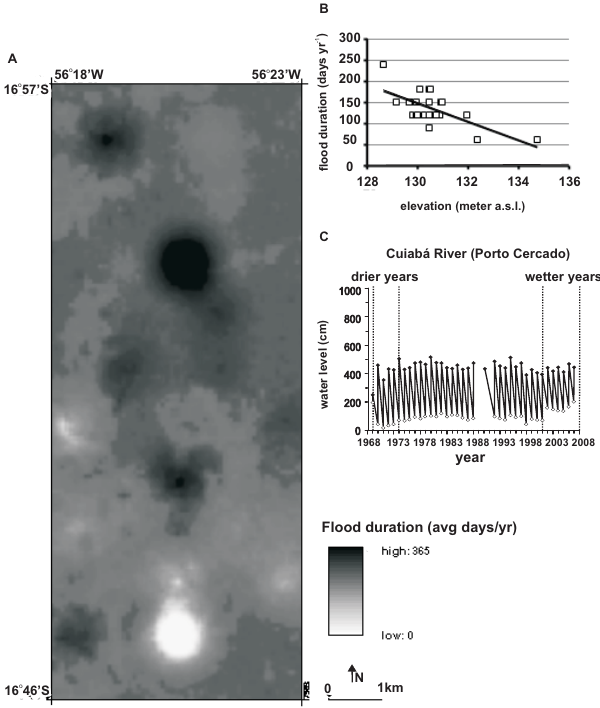
Fig. 9. (A) Map with average number of days flooded per year at the study site, calculated over the period 1969–2007; (B) relationship between flood duration (daysyr − 1 ) and elevation of the soil surface (ma.s.l.) observed at the 23 study transects; (C) water level fluctu- ation in the River Cuiab´a between 1969 and 2007. Vertical dotted lines indicate the occurrence of drier and wetter